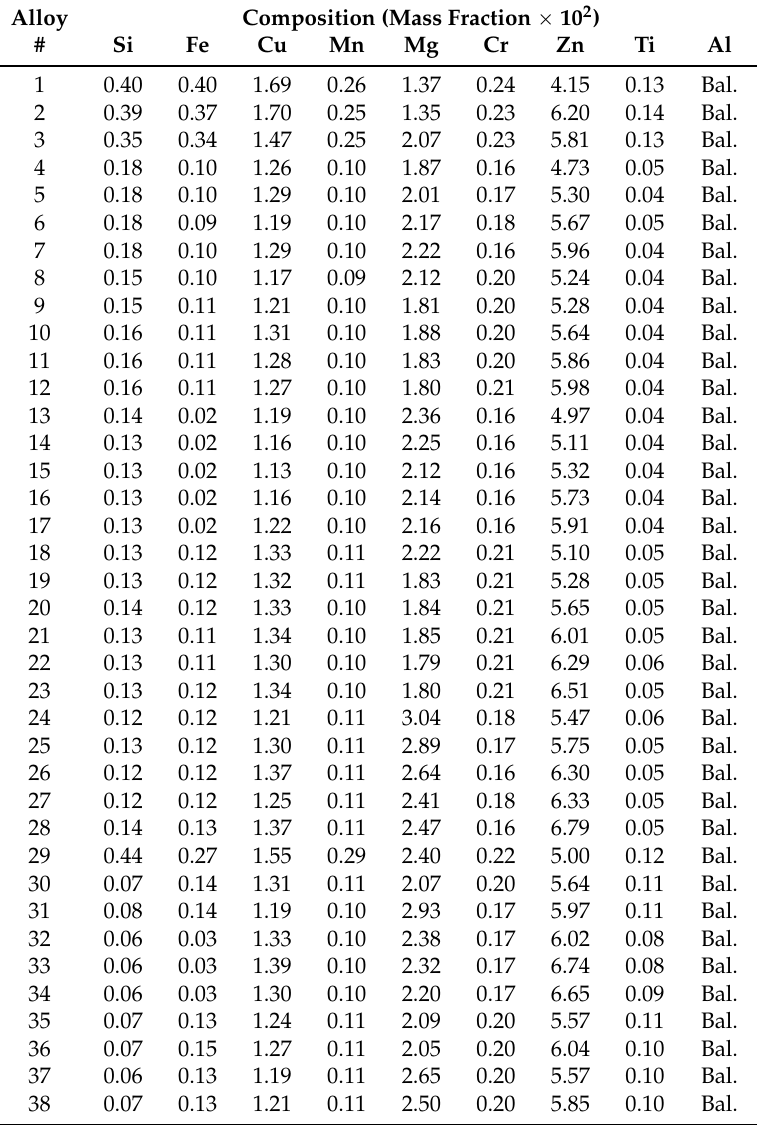
Table 1. Chemical composition of the alloys measured with emission spectrometry.